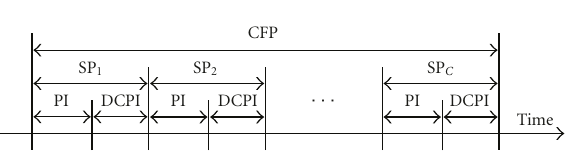
Figure 1: Modified CFP structure in